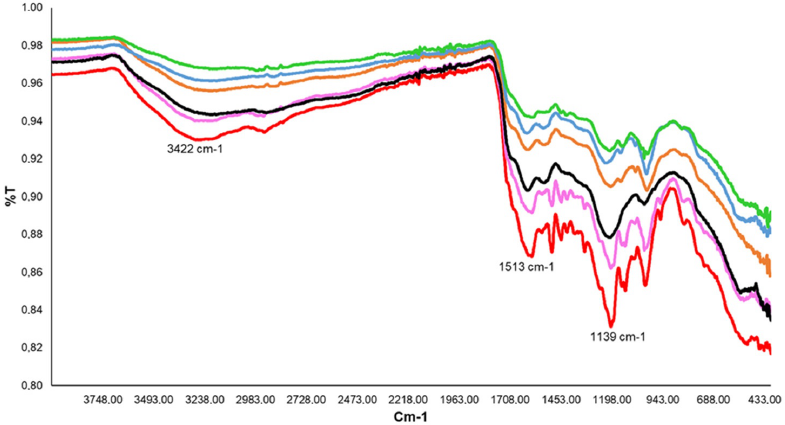
Figure 3. Attenuated total reflectance Fourier Transform Infrared spectroscopy (ATR-FTIR) of re- sidual sepia melanin after LMCS treatment with ABTS/V (blue line), TEMPO/V (orange line), Syr/V (pink line), As/V (blue line), and Va/V (red line). Original Sepia melanin (green line) is reported as a reference.